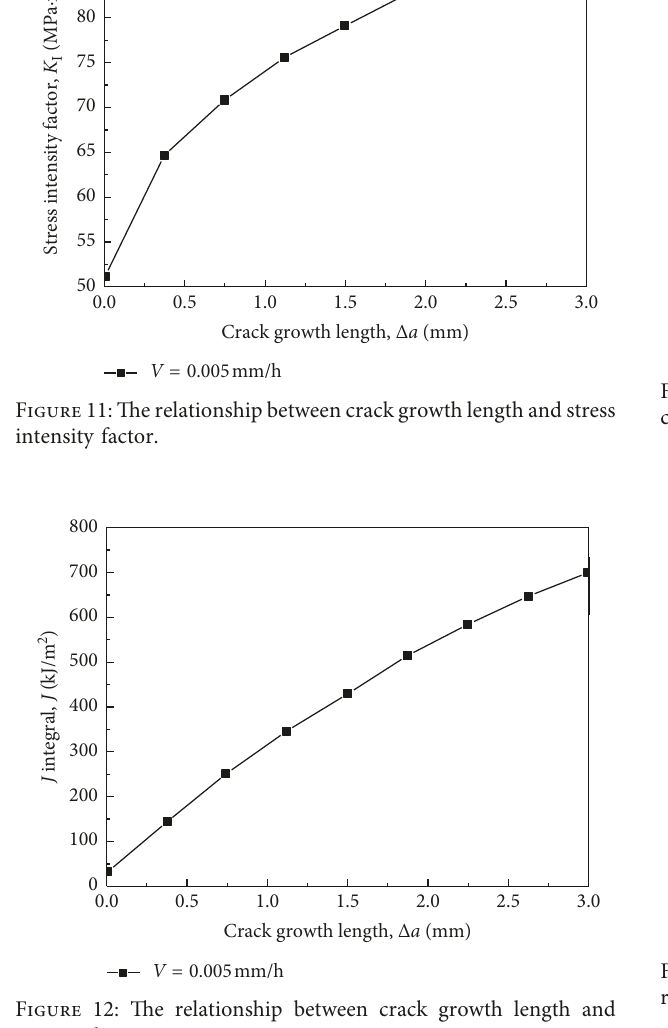
Figure 12: The relationship between crack growth length and J -integral.